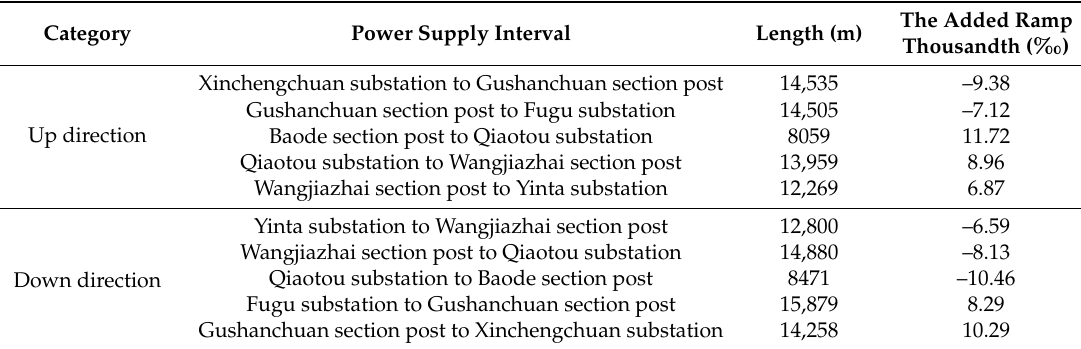
Figure 9. Shenshuo Railway line longitudinal section (part). Table 2. Shenshuo Railway line information